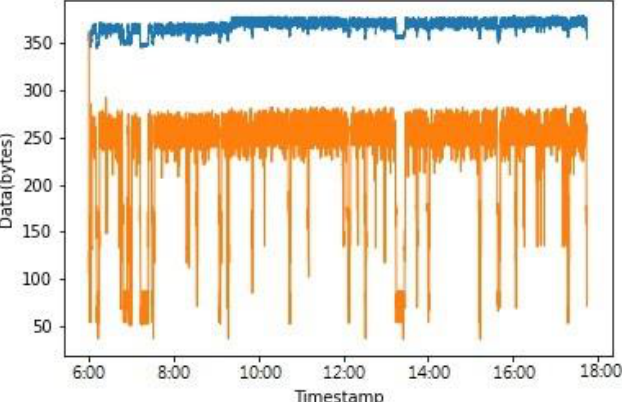
Figure 8. Reduce the length of uploaded data (using only Method I). Table 1. Average length of data (using only Method I).